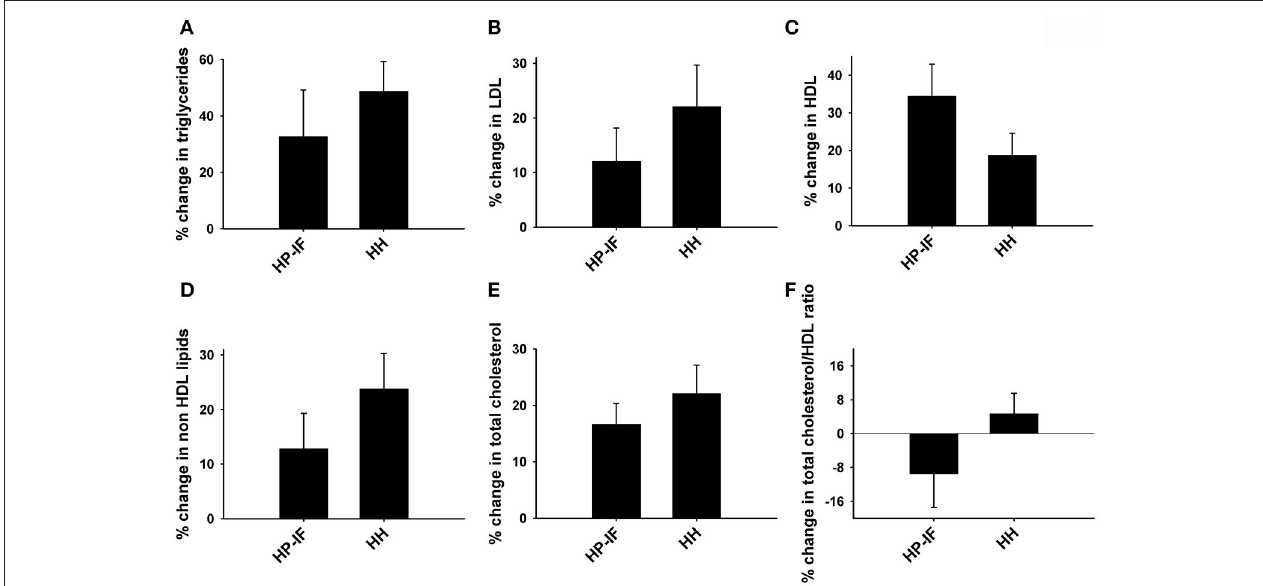
FIGURE 5 | Percent changes in (A) triglycerides, (B) LDL, (C) HDL, (D) non HDL lipids, (E) total cholesterol, and (F) total cholesterol/HDL ratio between the HP-IF and HH groups following Phase 2 (52 weeks). HP-IF, high-protein, intermittent fasting; HH, heart healthy; LDL, low-density lipoprotein; HDL, high-density-lipoprotein.